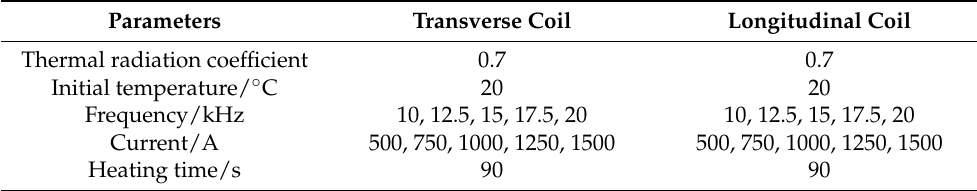
Table 4. Simulation